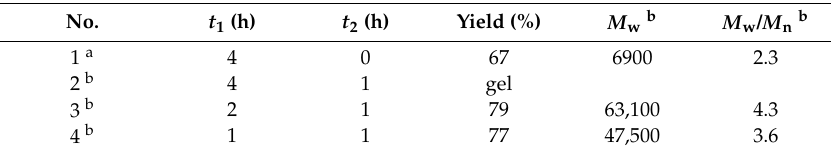
Table 2. BBr 3 -mediated polymerizations of 1 and 2 under different